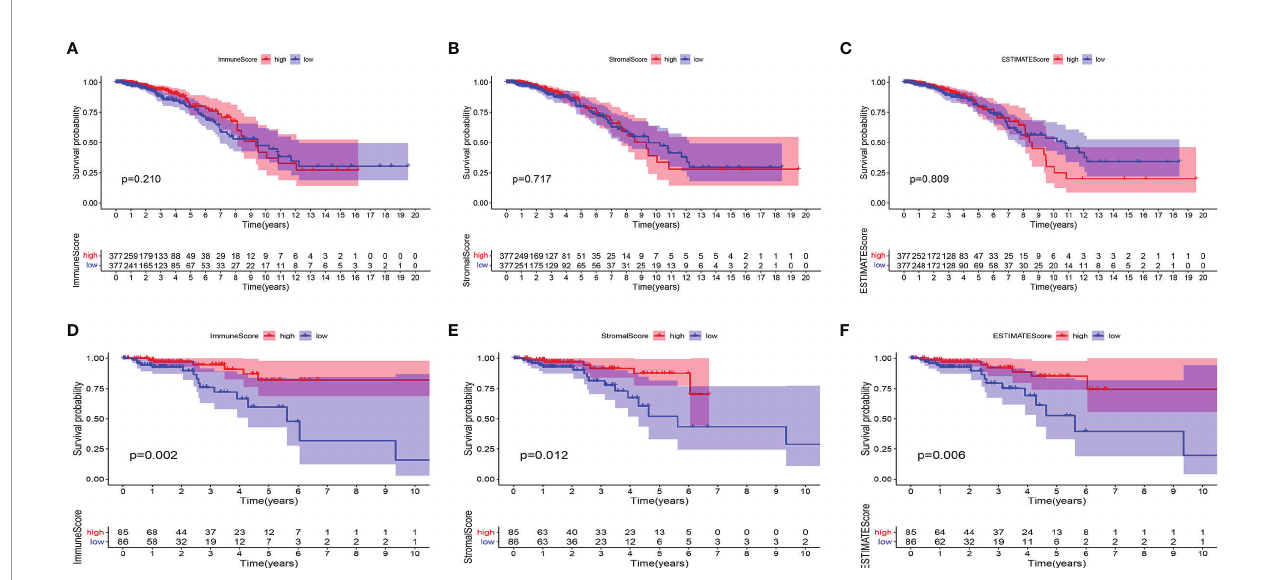
FIGURE 1 | Associations of ImmuneScore, StromalScore, and ESTIMATEScore with survival among BC or HER2+ BC patients. Kaplan – Meier survival analyses of breast cancer patients with low and high (A) ImmuneScores (p = 0.210), (B) StromalScores (p = 0.717), and (C) ESTIMATEScores (p = 0.809). Kaplan – Meier survival analyses of HER2+ BC patients with low and high (D) ImmuneScores (p = 0.002), (E) StromalScores (p = 0.012), and (F) ESTIMATEScores (p =